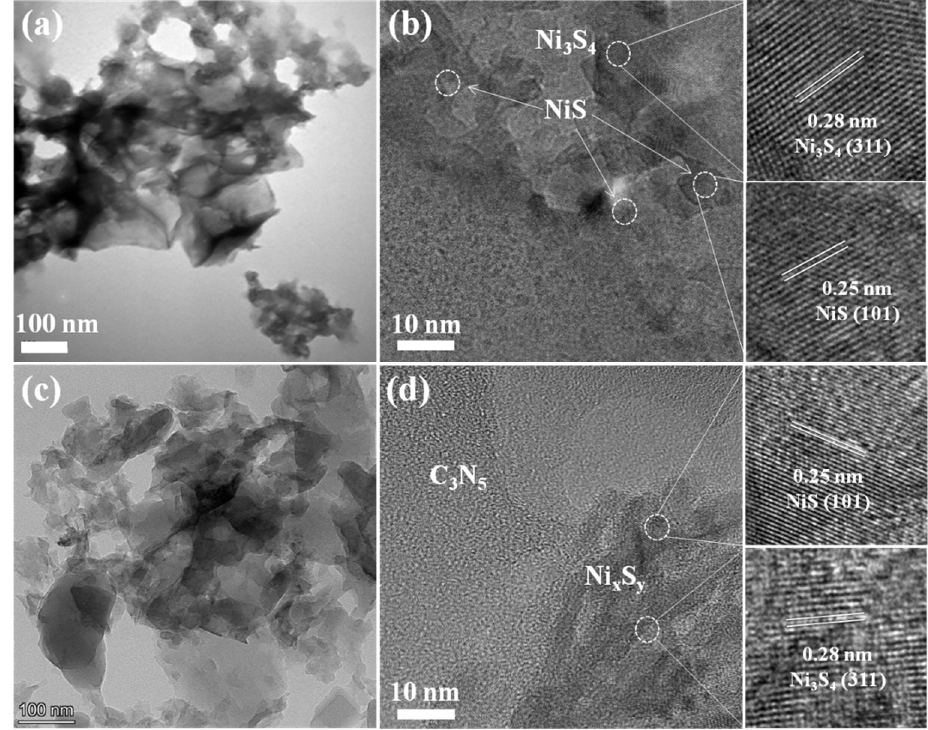
Figure 2. TEM and HRTEM images of Ni x S y ( a , b ) and 1.0 wt% Ni x S y -C 3 N 5 ( c , d ).